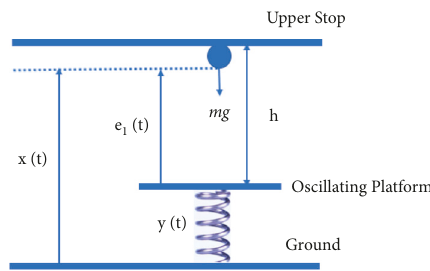
Figure 1: Bouncing ball dynamics (model).